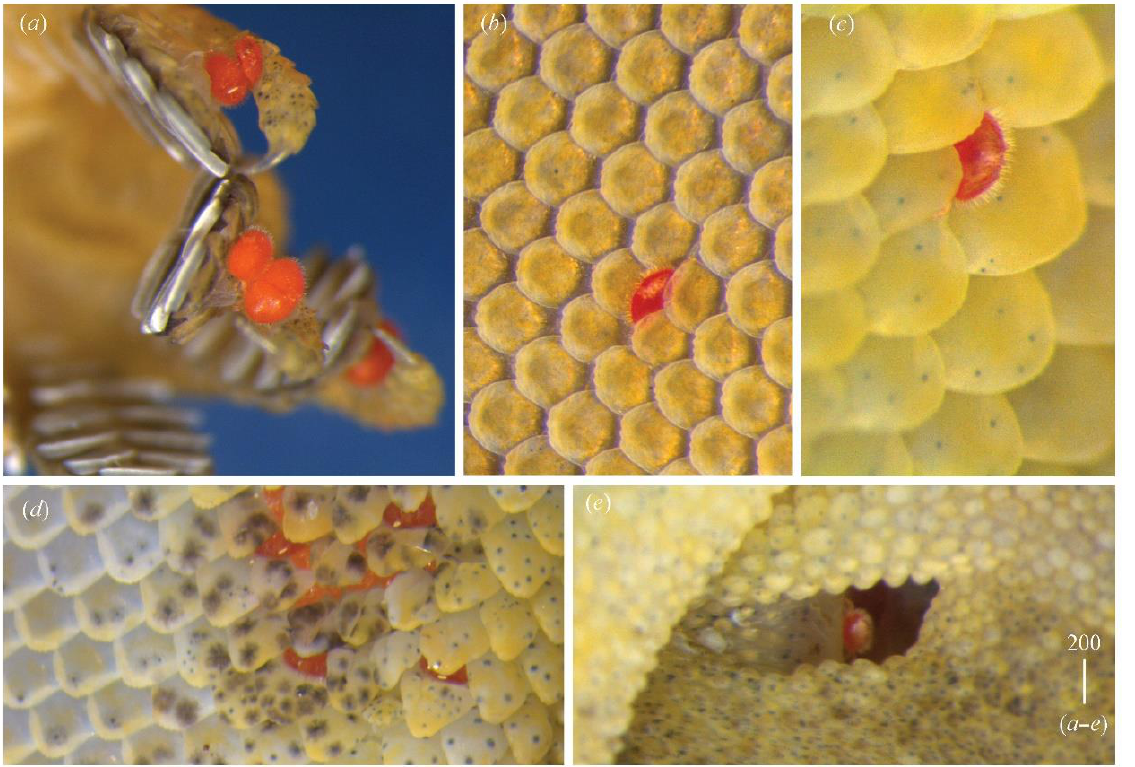
Figure 28. ( a ) Geckobia bataviensis Vitzhum, 1926 on toe of Hemidactylus frenatus Duméril and Bibron; ( b ) Geckobia sp. attached to H. cf. frenatus; ( c ) female of Geckobia phillipinensis under the ventral scales of H. frenatus ; ( d ) Geckobia indica Hirst, 1917 under the ventral scales of Hemidactylus treutleri Mahony; ( e ) males of Geckobia phillipinensis Lawrence, 1953 in tympanum of H. frenatus .